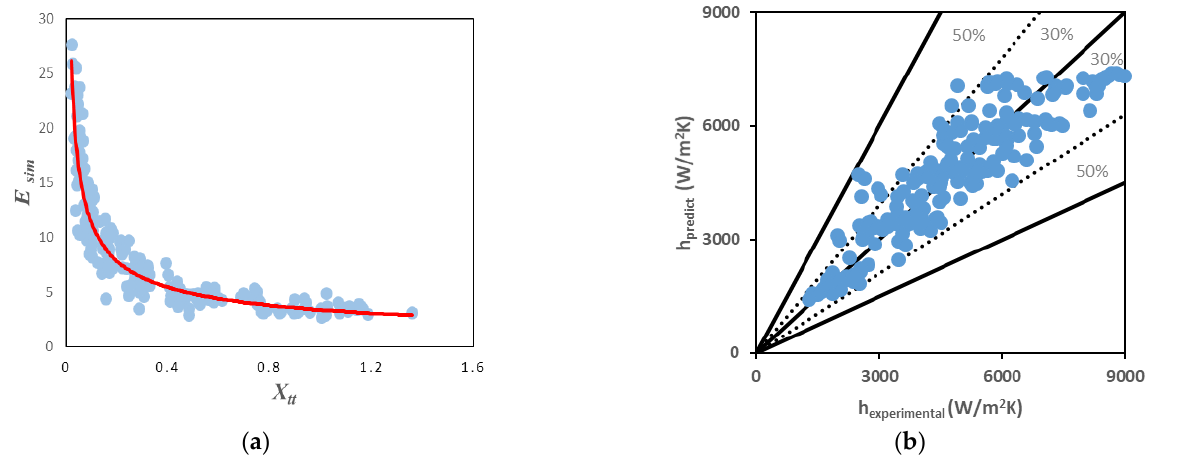
Figure 7. (a) Simplified enhancement factor E sim (Equation (24)) plotted against Lockhart– Figure 7. ( a ) Simplified enhancement factor E sim (Equation (24)) plotted against Lockhart–Martinelli Martinelli parameter. ( b ) Performance of the proposed correlation. parameter. ( b ) Performance of the proposed